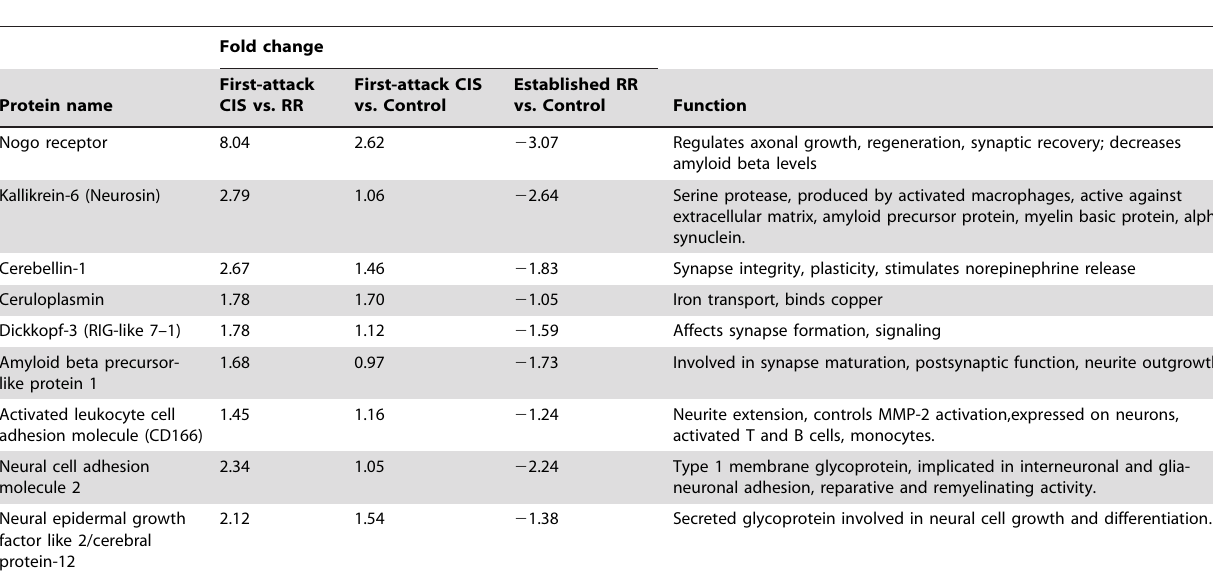
Table 1. Significant CSF Brain Protein Changes in first-attack CIS-MS vs. established RR-MS and Controls Increased in first attack CIS-MS vs. established RR-MS,